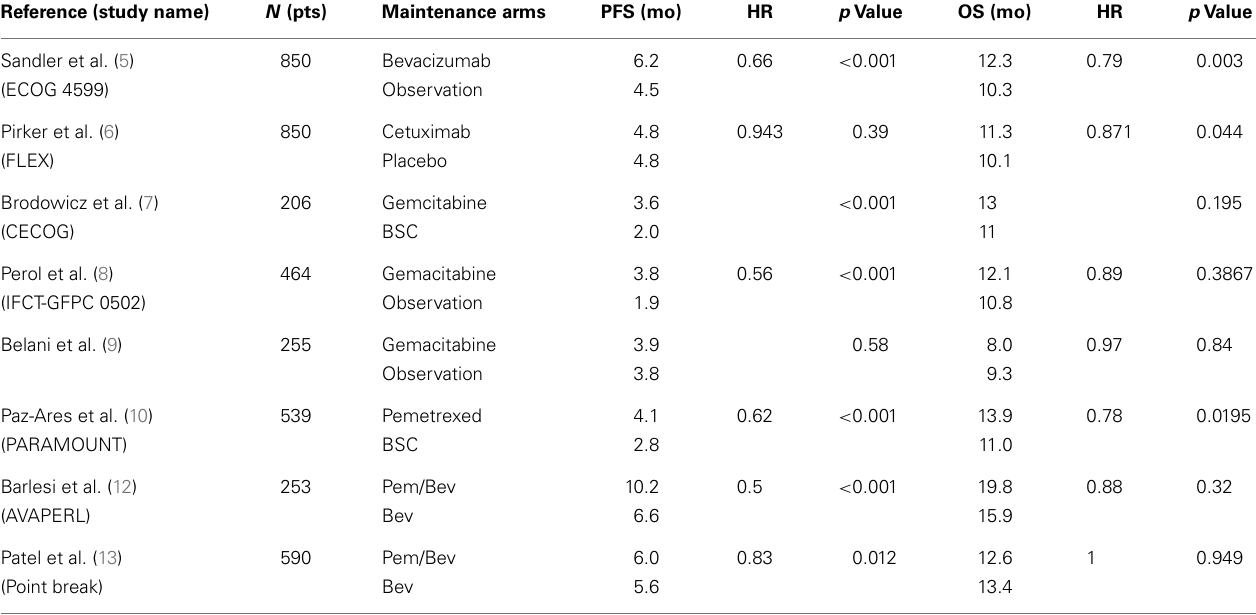
Table 1 | Key studies addressing continuous maintenance